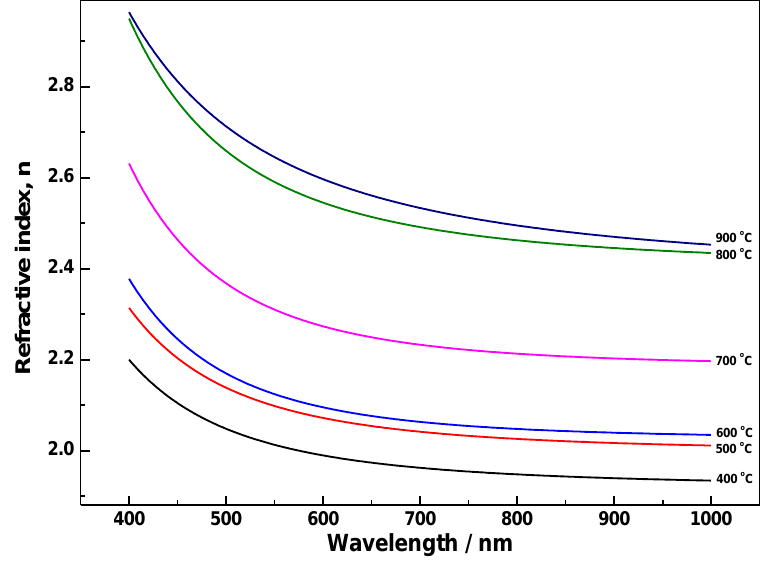
coatings annealed at different 2